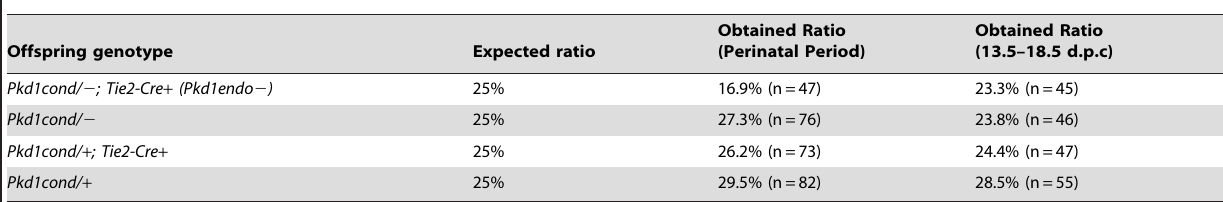
Table 1. Deletion of Pkd1 in endothelial cells.